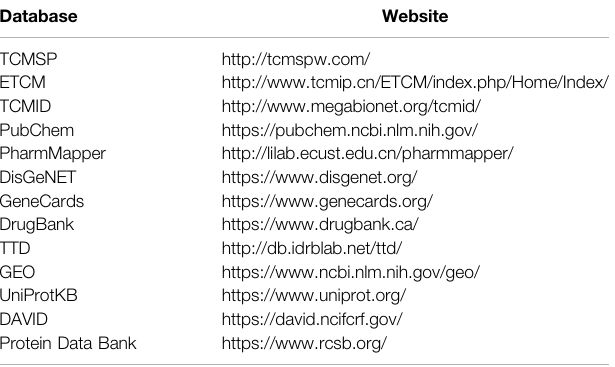
TABLE 1 | The websites of the databases used in this study.